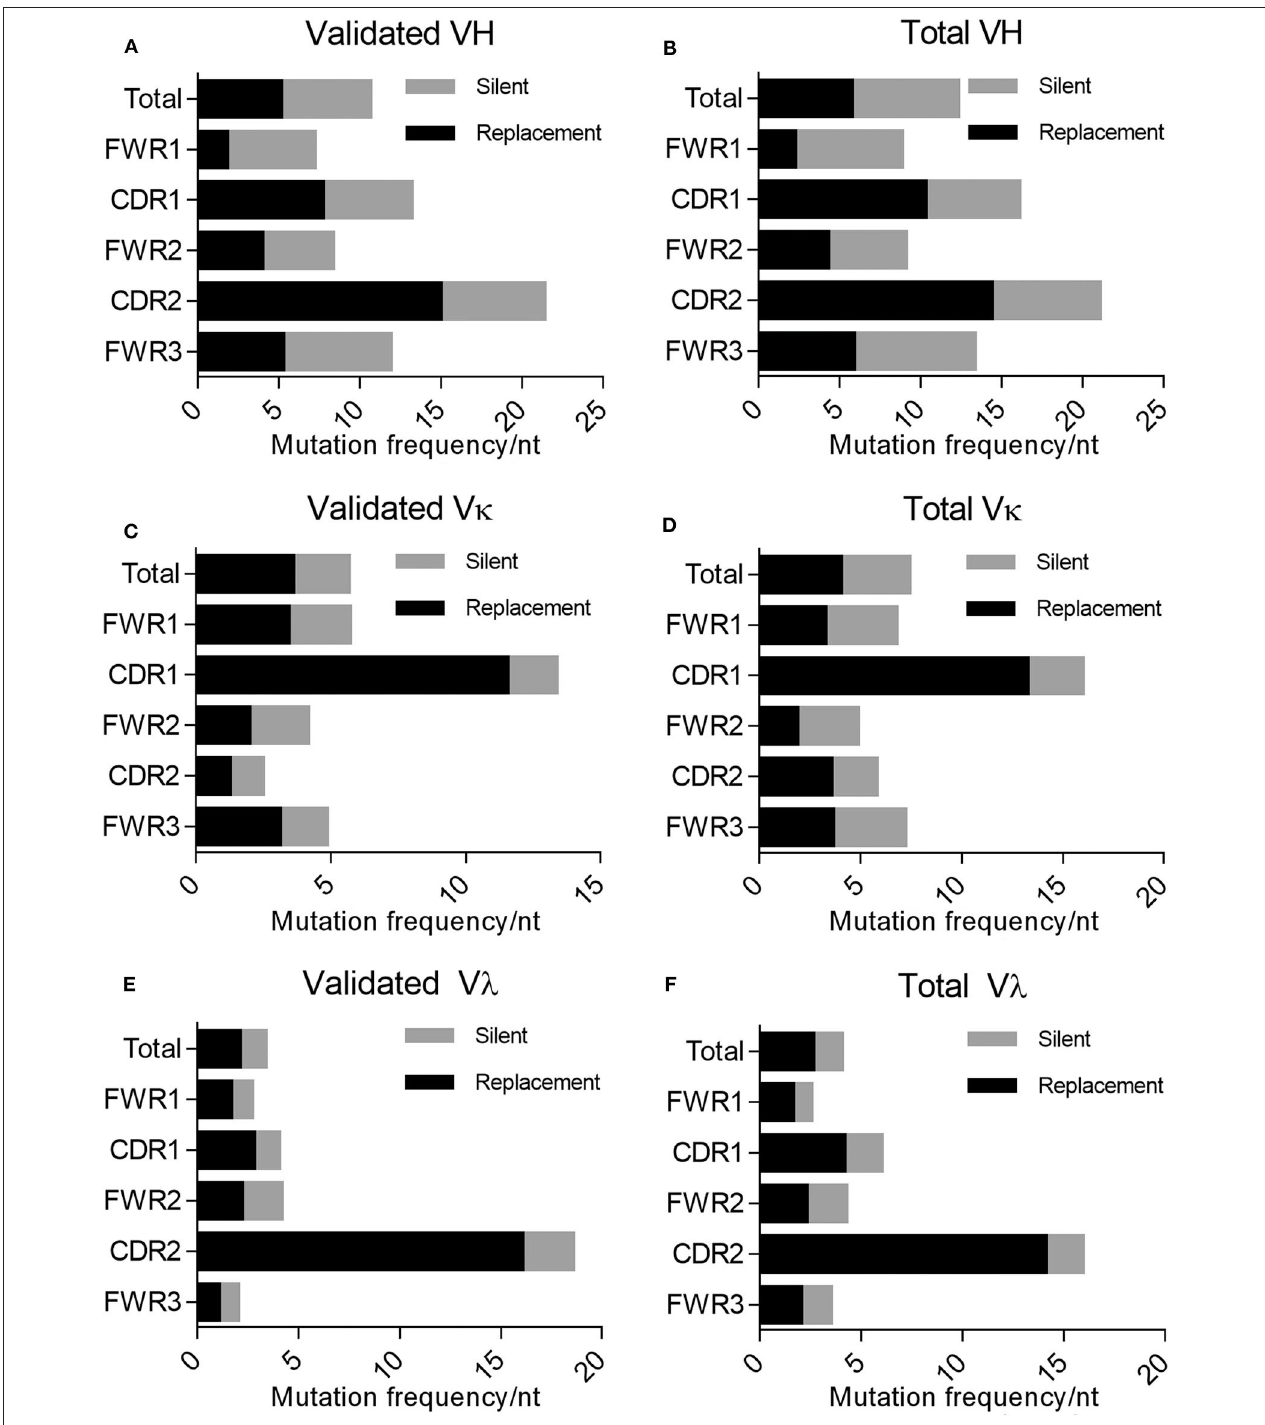
FIGURE 4 | Evaluating silent vs. replacement mutational frequency in AAV memory B cell-isolated variable chain sequences. Frequency of nucleotide substitutions resulting in amino acid substitutions (R, replacement) and frequency of nucleotide substitutions not resulting in amino acid substitutions (S, silent) were quantified (based on IMGT best germline DNA/protein sequences) for the complete isolated sequence (“total”), framework regions (“FWR1,” “FWR2,” “FWR3”), and complementarity determining regions (“CDR1,” “CDR2”). Frequencies were determined for validated (A) variable heavy, (C) variable kappa, and (E) variable lambda sequences as well as all isolated (B) variable heavy, (D) variable kappa, and (F) variable lambda sequences. R/S ratios were also calculated based on these frequencies; values are indicated to the right of bars. Data are displayed as means. We determined the frequency of nucleotide (nt) substitutions, defined as the percentage of positions containing a